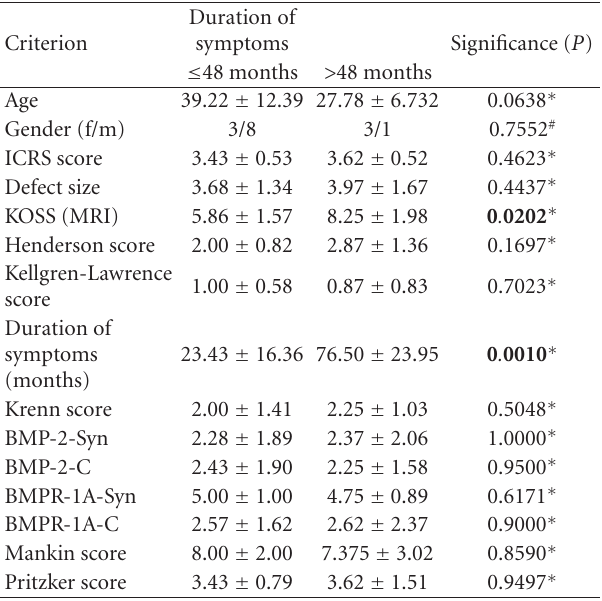
Table 3: Comparison between patients with di ff erent durations